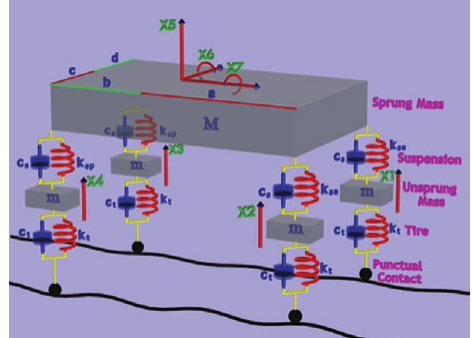
Fig. 2. The full car